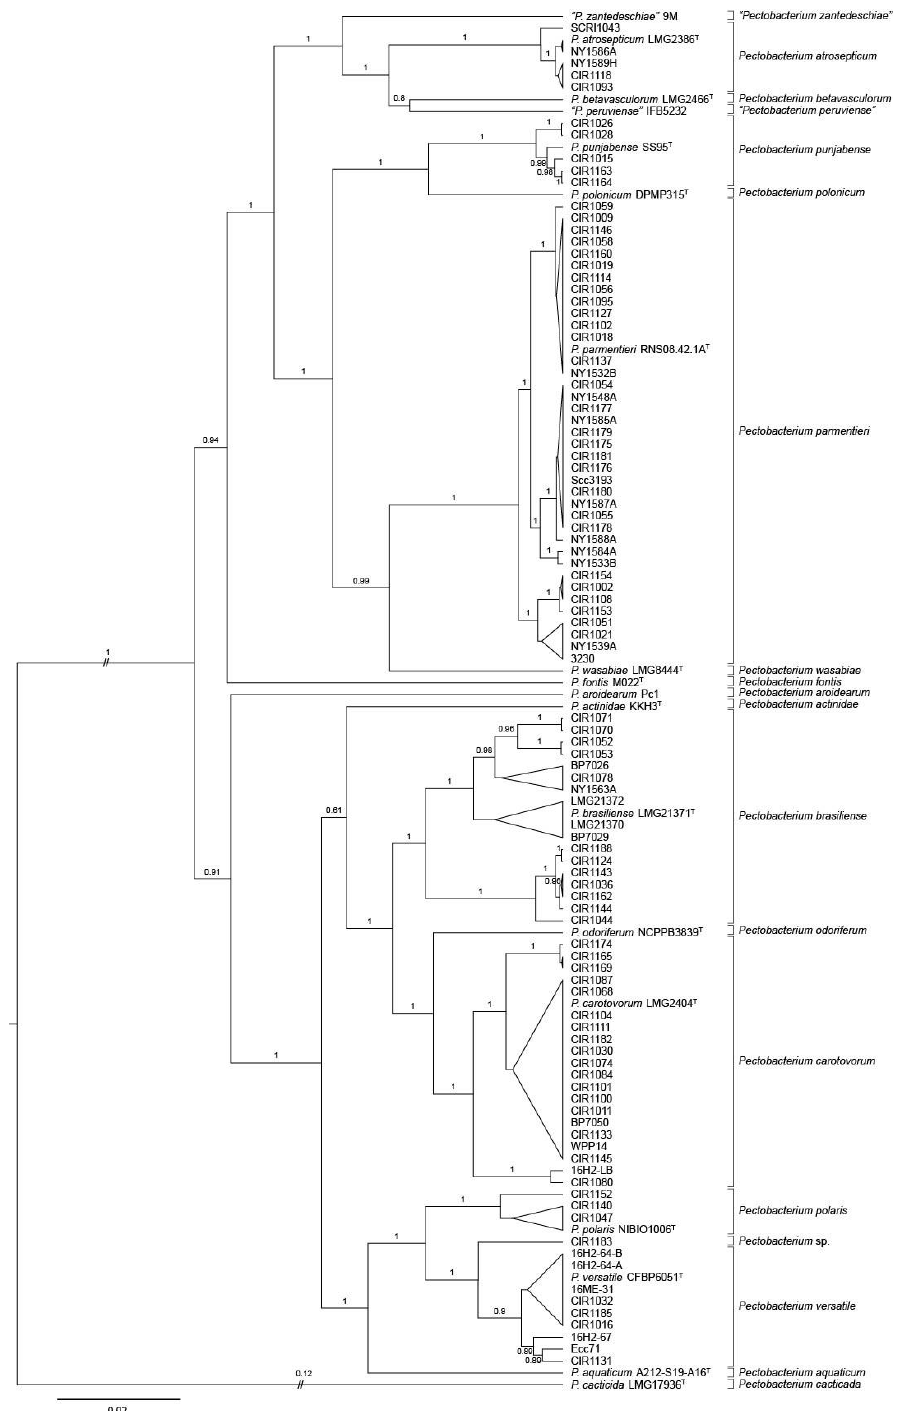
Figure 2. Bayesian tree of Pectobacterium spp. constructed from concatenated sequences of fragments of the genes dnaJ , dnaX , and gyrB of 92 strains collected in 2015 – 2016, 17 type strains, and seven historic reference strains. The superscript letter T indicates the species type strain. Posterior probabilities > 0.6 are shown at the corresponding node. Branch lengths are drawn to scale and represent sequence changes since the common ancestor.